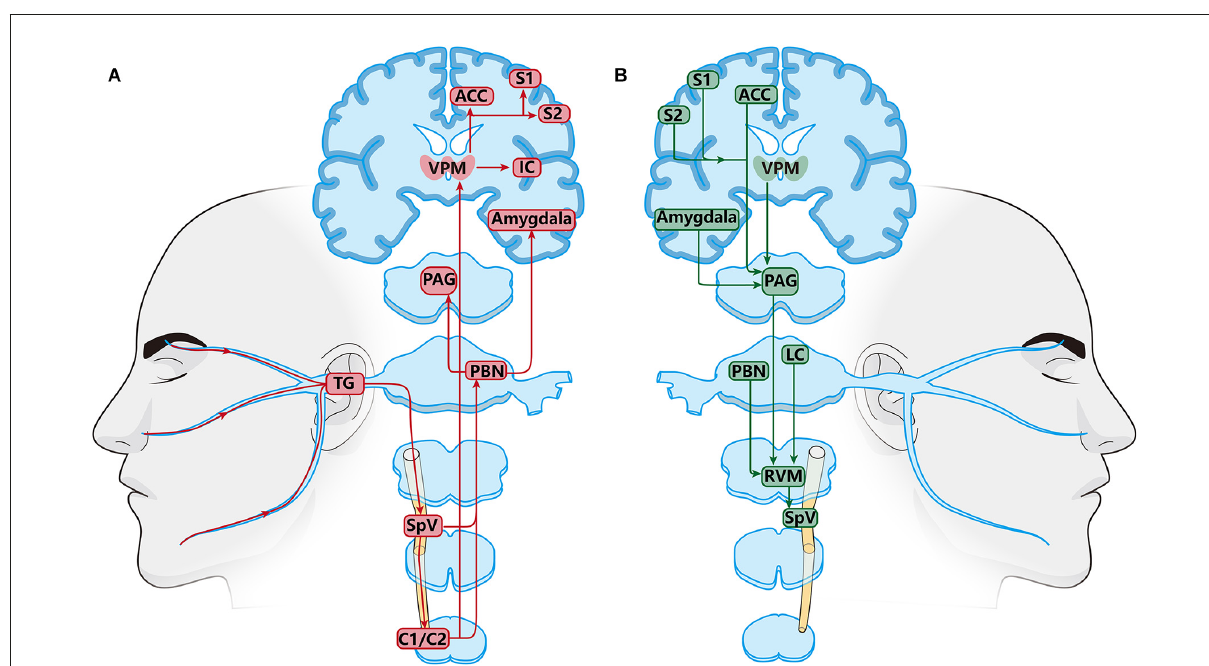
FIGURE1 Schematic diagram of the orofacial pain modulation circuits. (A) Ascending nociceptive modulatory pathway. Neurons in the posteromedial thalamic nucleus (PBN) and thalamus (VPM) are key relays in ascending transmitting pathway. PBN and VPM receive nociceptive information from the SpVi/c, Vc, C1/C2 and project upward to the amygdala, anterior cingulate cortex (ACC), insular cortex (IC), the primary somatosensory cortex (S1), and secondary somatosensory cortex (S2). (B) Descending pain modulatory pathways. Periaqueductal gray (PAG), and ventrolateral medulla (VPM) are the main relays in the descending pain regulation pathway. The PAG receives regulatory information from the amygdala, VPM, ACC, S1, and S2, and finally transmits it down to the SpV through the RVM. TheRVM receives direct inputs from the PAG, thalamus, parabrachial region, and locus coeruleus